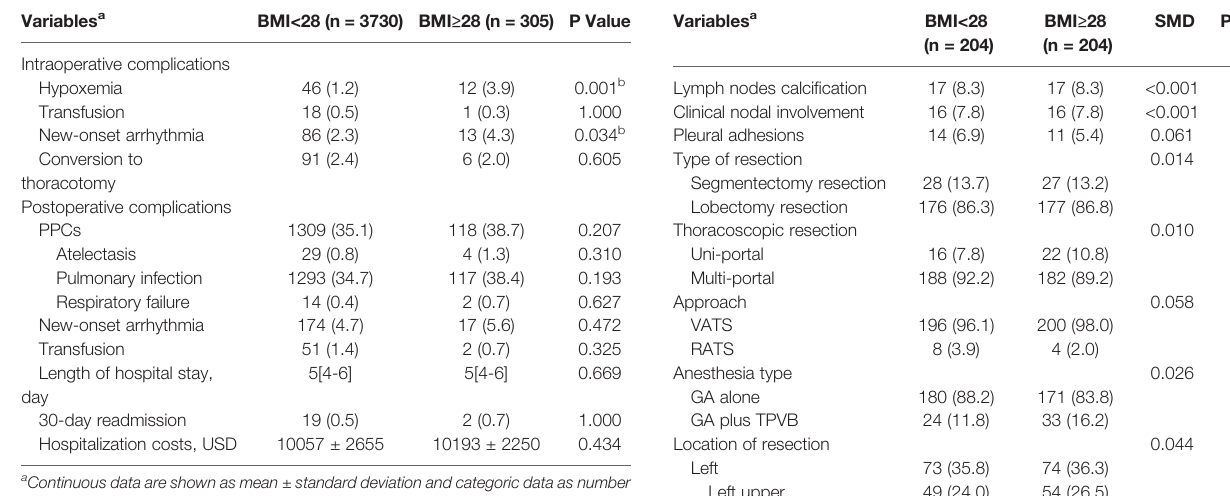
TABLE 5 | Intraoperative characteristics strati fi ed by BMI after a 1:1 PSM. TABLE 3 | Intra- and postoperative complications strati fi ed by